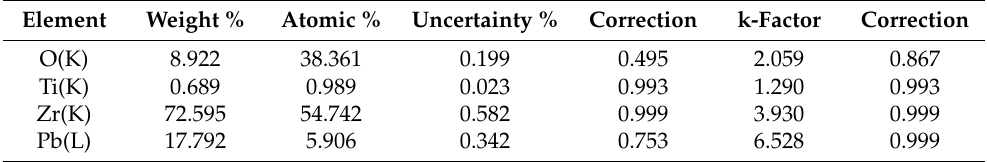
Figure 8. EDS of TEM of the PZTN ( x = 0.04) sintered at 1260 °C for 2 h. Table 1. Elements analysis by EDS of the PZTN ( x = 0.04) sintered at 1260 °C for 2 h.